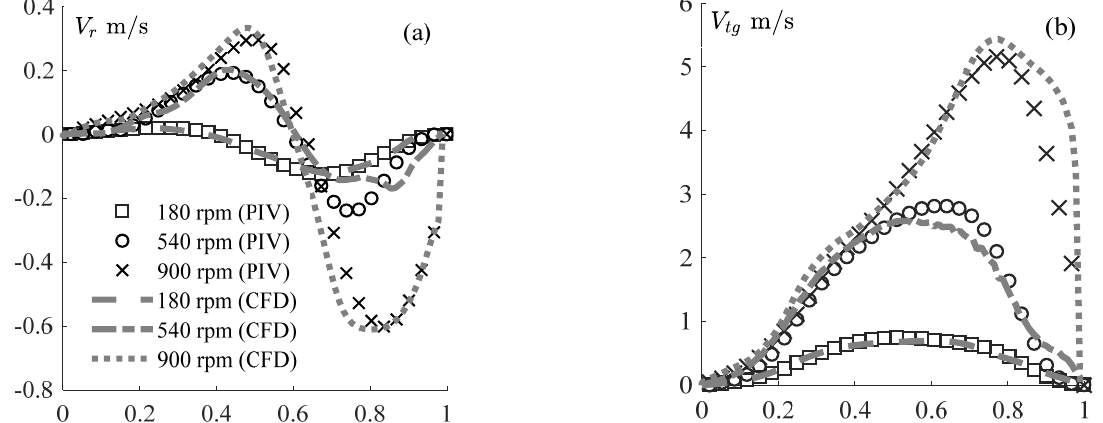
Figure 10. Comparison between the numerical and experimental ( a ) radial and ( b ) tangential profiles above the air–water interface at Ω = 180, 360, 720, and 900 rpm.